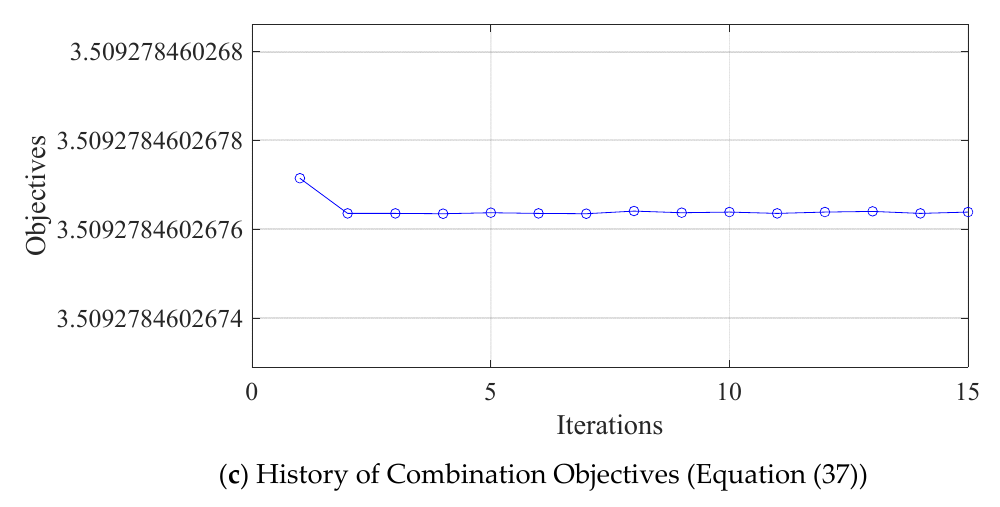
Figure 19. History of objectives for retargeting control optimization.